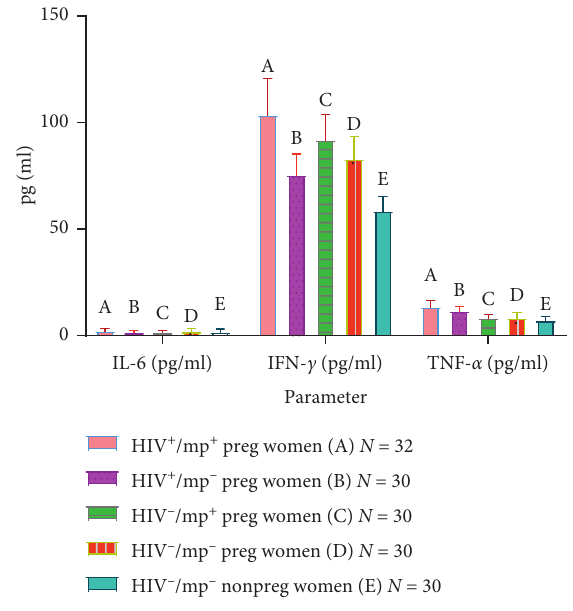
Figure 2: Comparison of mean ( ± SD) plasma levels of IL-6, IFN- c , and TFN- α in test group and control group. Key: IL-6 in B and C vs A, D, and E ( p � 0 . 008). IL-6 in A vs B and C (p � 0 . 005 , p ≤ 0 . 003, respectively). IFN- c in A vs B, C, D, and E ( p ≤ 0 . 001). IFN- c vs CD ( p � 0 . 014). IFN-in C vs D and E ( p � 0 . 003 , p ≤ 0 . 001. D vs E ( p ≤ 0 . 001). TNF- α in A and B vs E ( p ≤ 0 . 001). Table 1: Correlation of inflammatory markers, with some an- thropometric parameters in HIV seropositive pregnant partici- pants with/without malaria and control